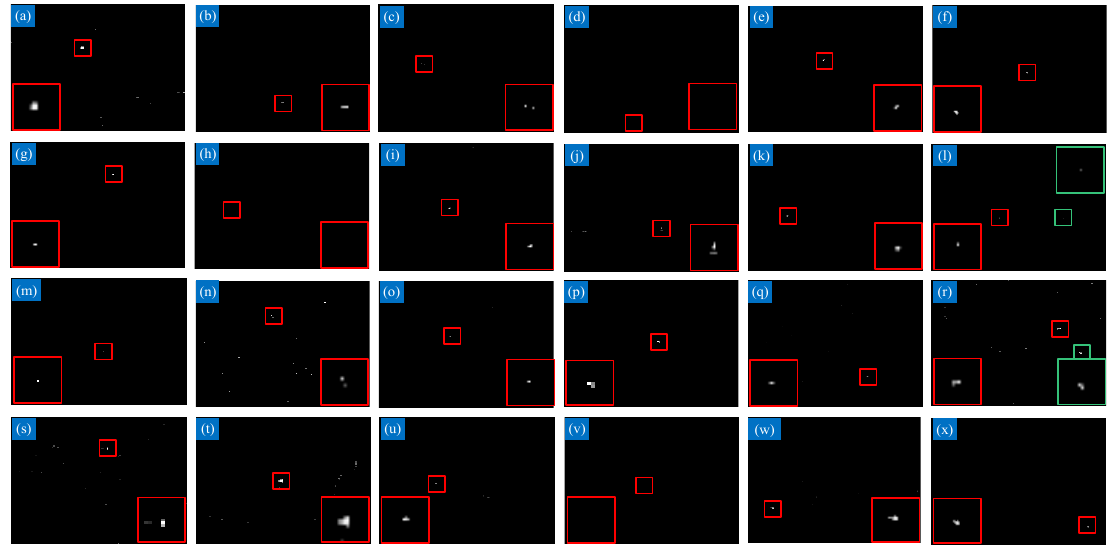
Figure 12. The separated target images of the RIPT model under 24 scenes.